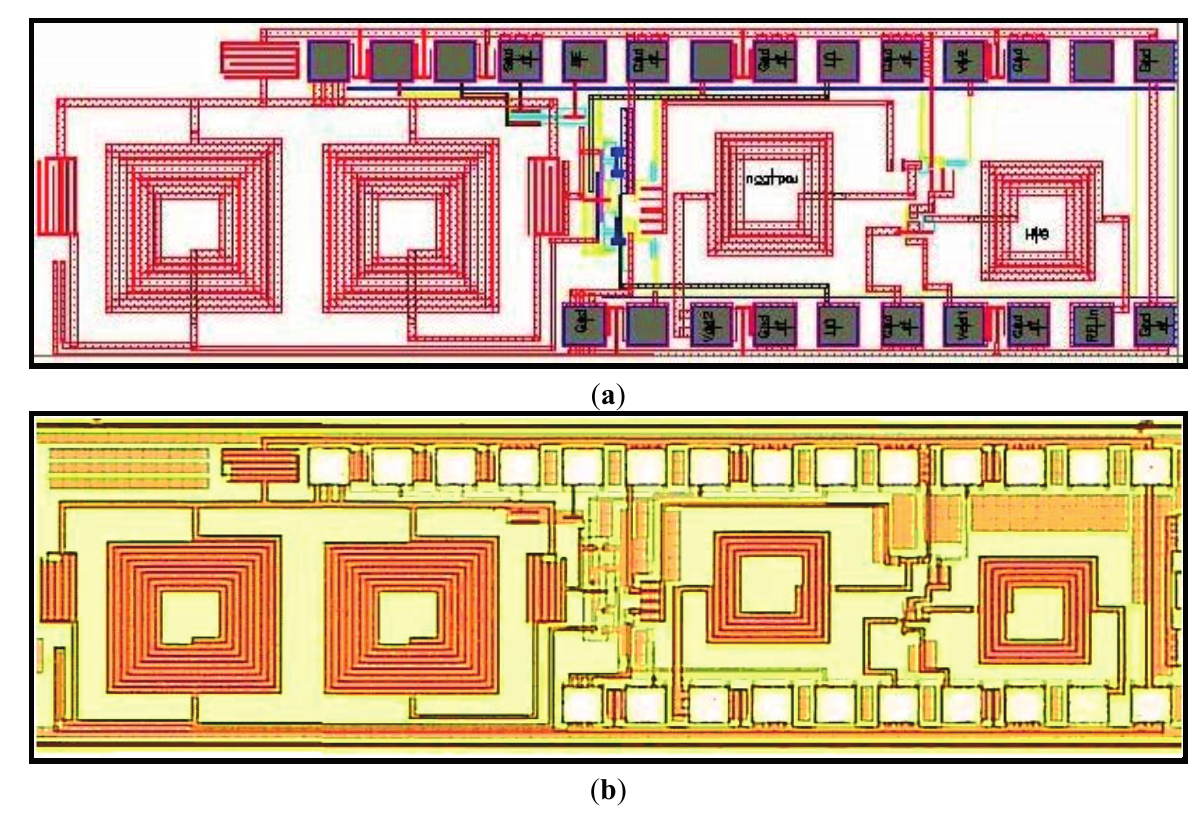
Figure 5. ( a ) Layout; ( b ) Die micrograph of receiver